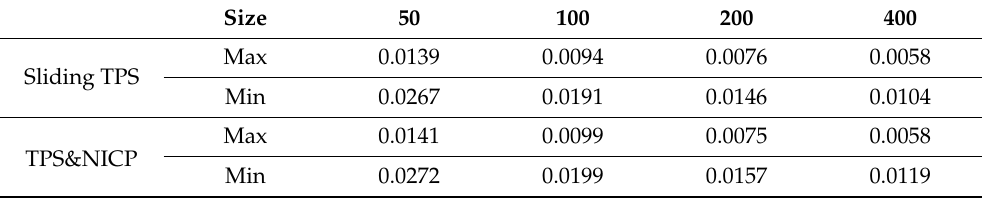
Table 8. Procrustes distances between vertices of the estimated predictions of ape cranial surfaces at the maximum and minimum centroid sizes derived from the maximum density of semilandmarks and those from lower densities of semilandmarks after re-semilandmarking and re-warping.